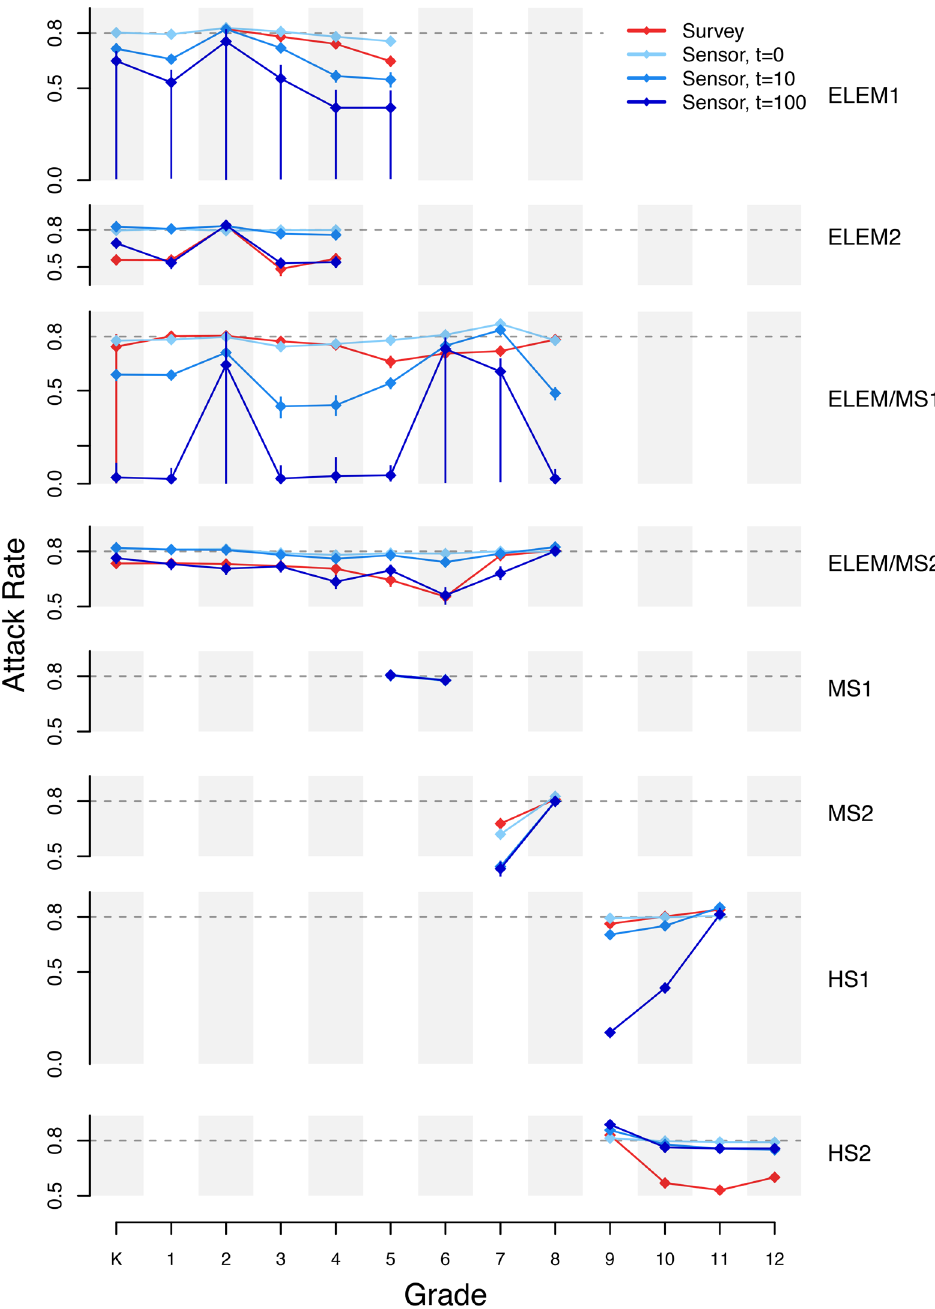
Figure 4. Grade-specific final predicted attack rates of a respiratory virus in a US school setting, based on stochastic simulation using mixing matrices of in-school survey contacts and unique sensor-recorded contacts at various contact thresholds, adjusted by proportionate mixing expectations, within each school (ELEM, elementary; MS, middle school; HS, high